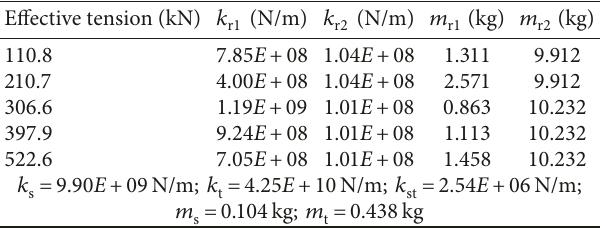
Table 2: Mass and stiffness values of the FSSB and anchorage nut of the test model.